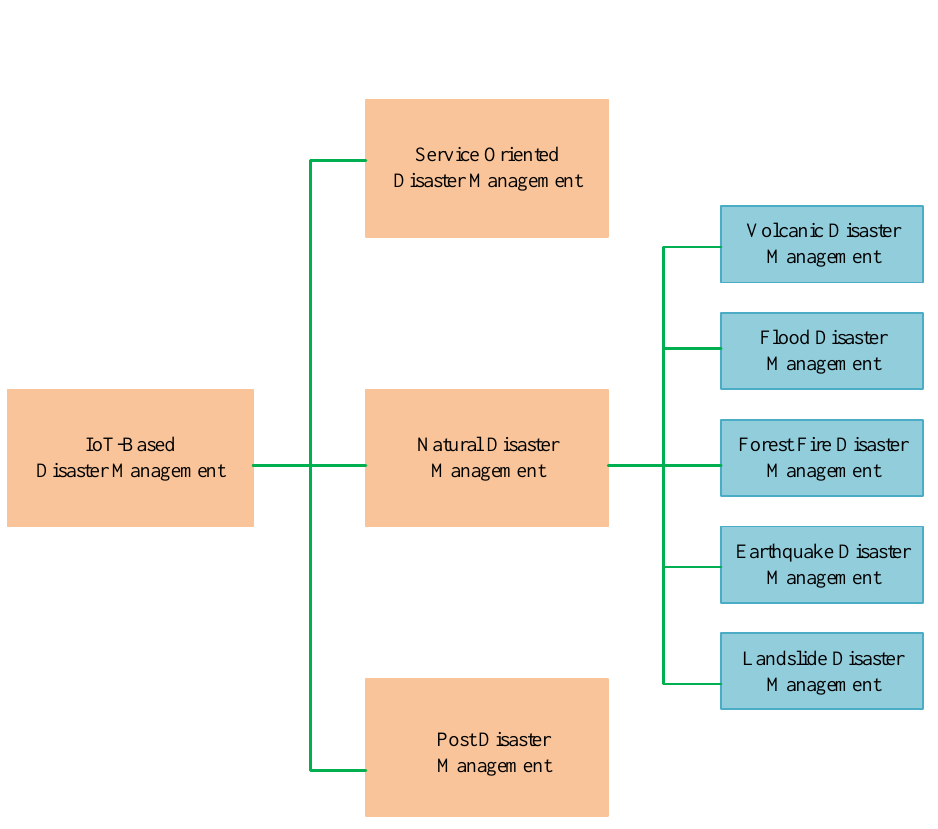
Figure 6. The taxonomy of DMS based